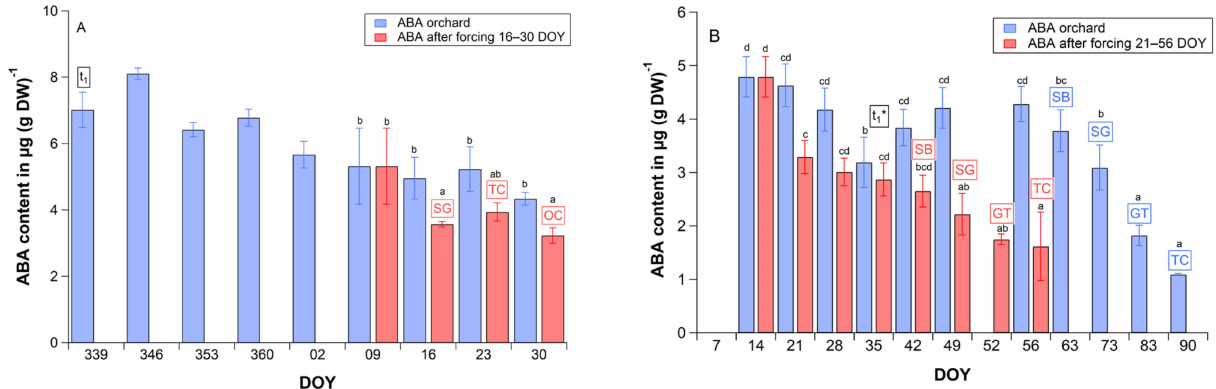
Figure 6. ( A ) Weekly ABA content of ‘Summit’ cherry flower buds ( A ) between endodormancy release (t 1 = 339 DOY) and 30 DOY in the orchard (blue bars) and between 9 and 30 DOY under forcing conditions (red bars, ∼ 24 ◦ C, 12 h light, 70% relative humidity) in 2019/20, ( B ) between 14 and 90 DOY in the orchard (blue bars) and between 14 and 56 DOY under forcing conditions (mean weekly temperature 8.0–12.0 ◦ C, red bars) in 2013/14. t 1 *: beginning of ontogenetic development, SB: ‘swollen bud’, SG: ‘side green’, GT: ‘green tip’, TC: ‘tight cluster’, OC: ‘open cluster’. Error bars show the standard deviation of the repetitions ( n = 3). Different letters indicate significant differences within the orchard and forcing experiment, ANOVA, Tukey-HSD test ( p ≤ 0.05), DOY: day of